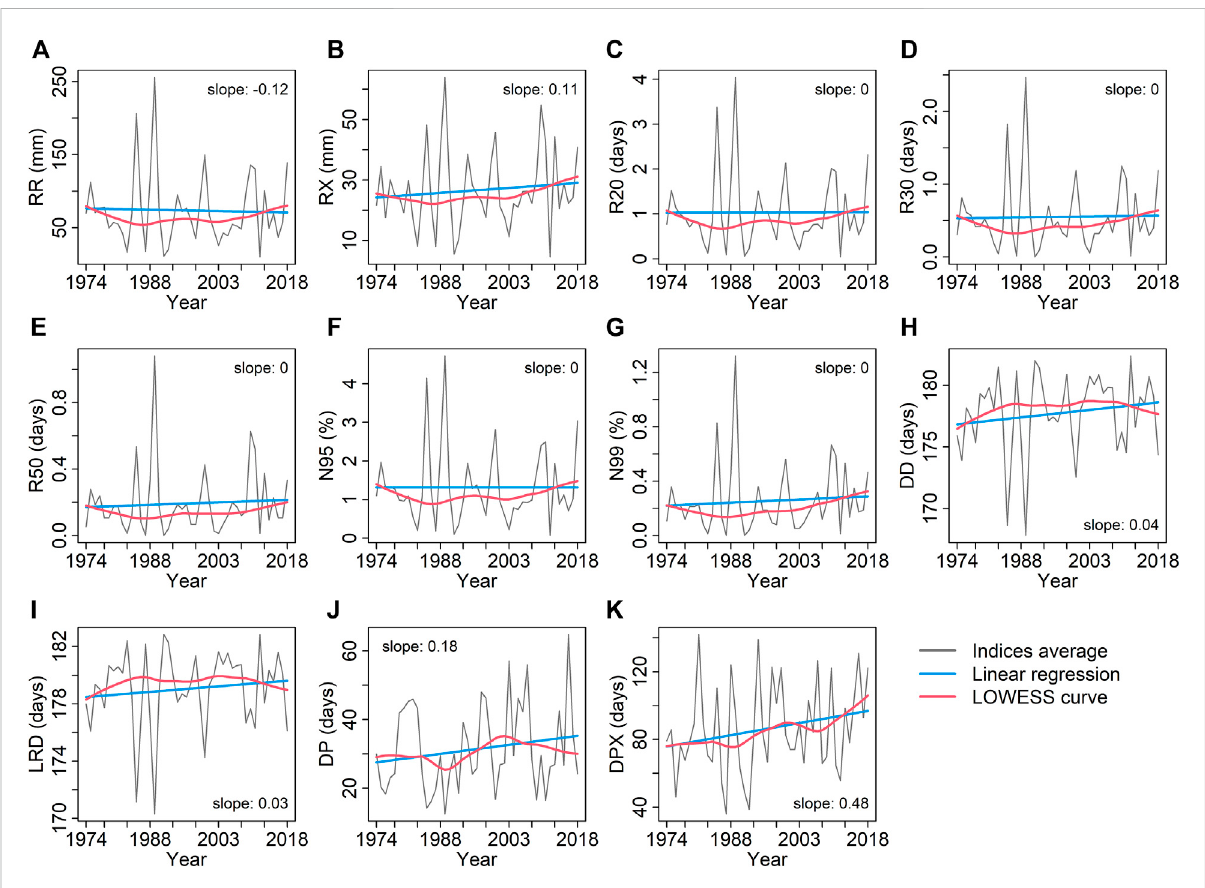
FIGURE 6 LOWESS curve (red line) and linear regression (blue line) related to (A) RR, (B) RX, (C) R20, (D) R30, (E) R50, (F) N95, (G) N99, (H) DD, (I) LRD, (J) DP and (K) DPX of target stations during the dry season from 1974 to 2018. The number refers to a slope of linear regression. The * symbol indicates the slope was signi fi cant at the 5%